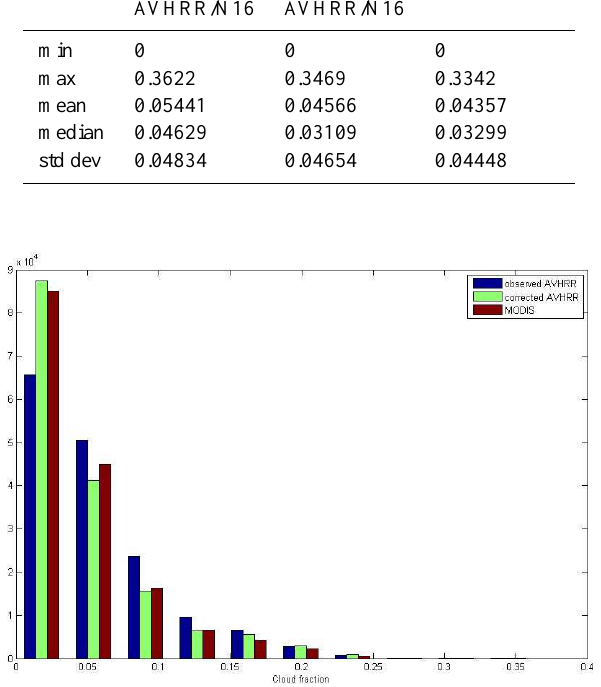
Fig. 8: Frequency distribution of optically thick convective cloud fraction (BT<220 K) for JJAS 2006 for original and corrected AVHRR data compared with MODIS over the study area.